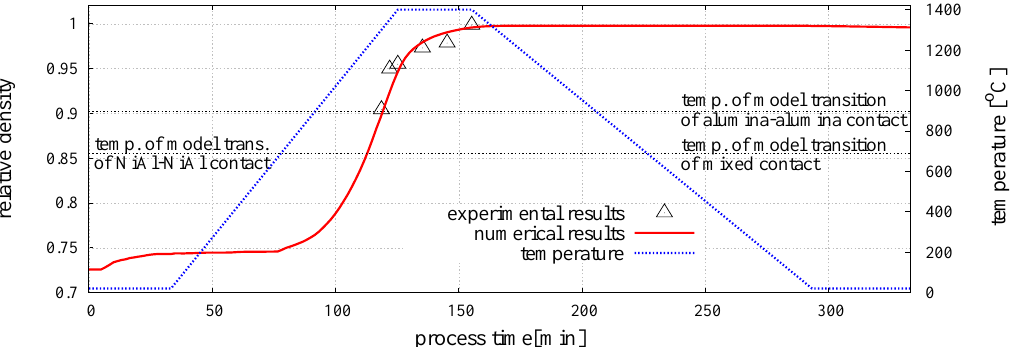
Figure 6. Evolution of the relative density of the mixture of NiAl–Al 2 O 3 powder [39].